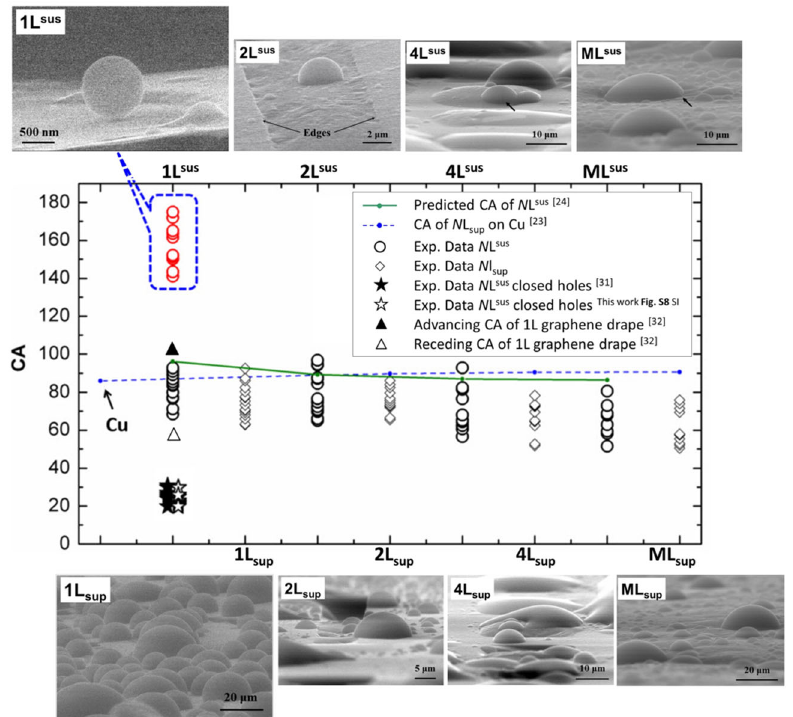
Fig. 4 Wettability on supported and on suspended monolayer and multilayer graphene. (circles) Contact angles, CA or θ (deg), of droplets on suspended: 1L sus , 2 L sus , 4 L sus , and ML sus , and (diamonds) contact angles of droplets on supported: 1L sup , 2L sup , 4L sup , and ML sup where N refers to the number of layers. For each case, 10 to 20 independent CA measurements are reported. Theoretical CA trend based on the minimum Lennard-Jones (L-J) potential for suspended graphene as in ref. 24 is plotted as a green solid line, while blue dashed line includes theoretical CA calculation of supported graphene on copper (Cu) from ref. 23 , for comparison. ESEM snapshots of (top) droplets on 1L sus , 2L sus , 4L sus and ML sus samples, and (bottom) droplets on 1L sup , 2L sup , 4L sup and ML sup samples are also included for comparison. Non-wetting droplets on 1L sus are represented as red circles. CA measurements of wetting droplets on suspended monolayer graphene supported over a TEM grid with closed holes from (open stars) our work Fig. S8(b) in the accompanying Supplementary Note 3 and (closed stars) the work of Zhang et al. 31 are included for comparison. Advancing CA (closed triangles) and receding CA (open triangles) of large-area 1L graphene drape from ref. 32 are also included (note that the x-axis representation for suspended monolayer graphene with closed holes is slightly shifted so that the two conditions can be readily identi fi